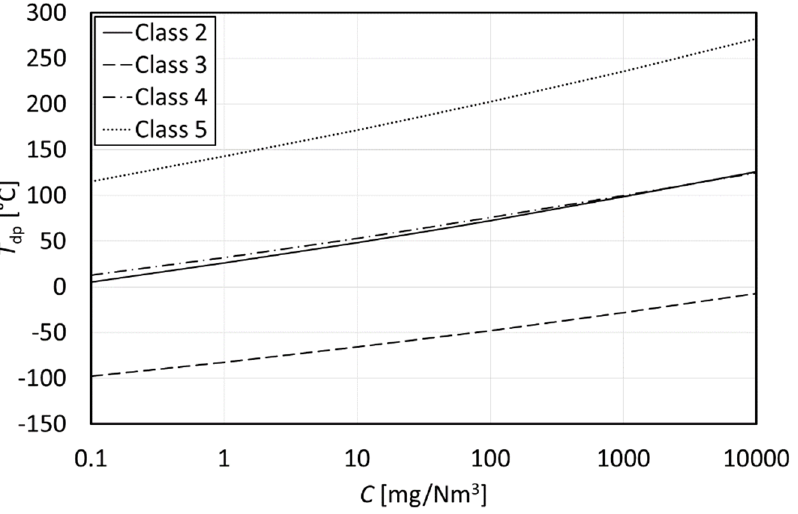
Figure 1. Tar dew point for different tar classes as a function of tar-class concentration.